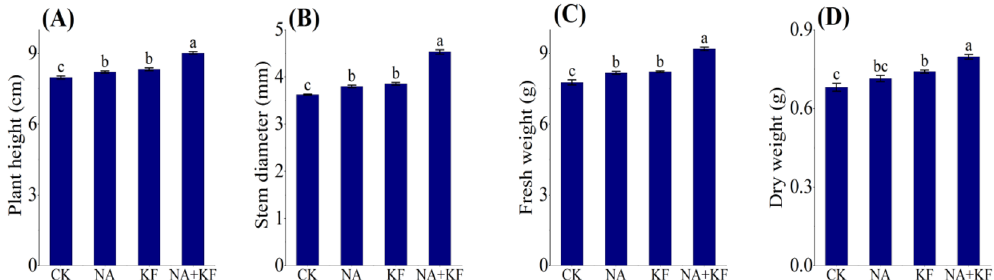
Figure 1. Effects of different treatments on plant height, stem diameter, fresh weight and dry weight of tomato seedlings. ( A ) Plant height, ( B ) stem diameter, ( C ) fresh weight, ( D ) dry weight, NA, 5 mg·kg −1